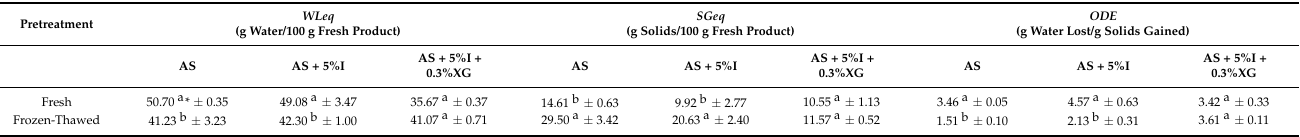
Table 2. Equilibrium and efficiency ratio of fresh and frozen-thawed mango during osmotic dehydration.